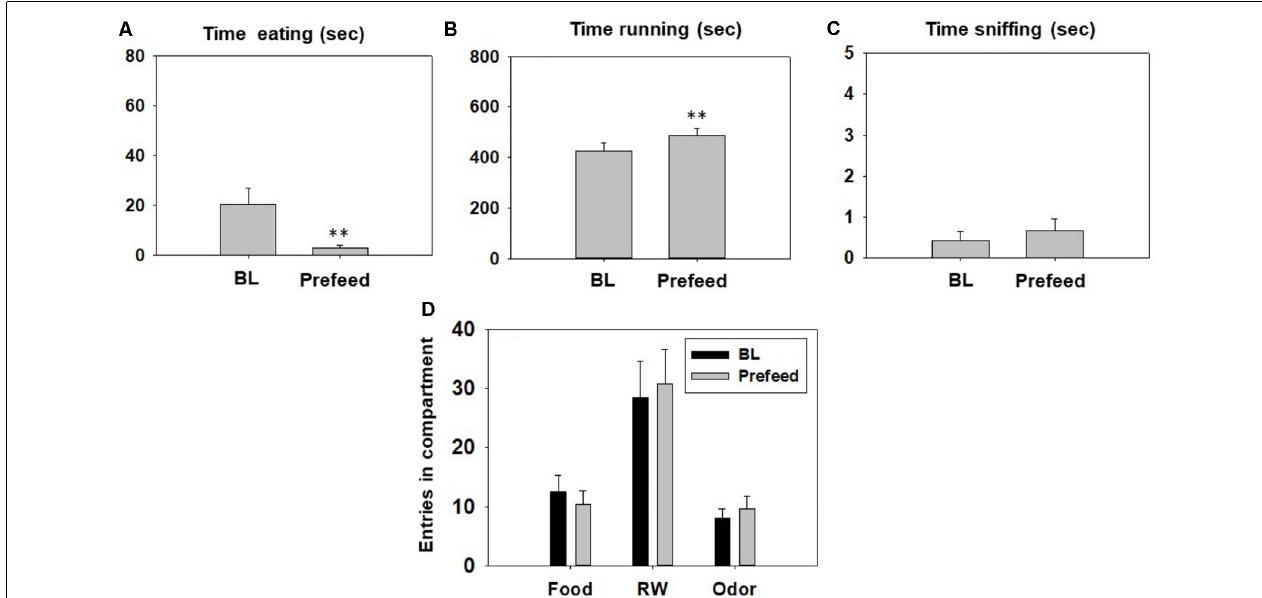
FIGURE 7 | Effect of pre-feeding on time eating (A) , time running (B) , time sniffing (C) , entries into compartments (D) , and in the T-maze task assessed during 15 min. Data were analyzed using the Student’s t -test for dependent samples. Bars represent mean ± SEM of accumulated seconds or number of entries. ∗∗ p < 0.01 significantly different from BL condition.